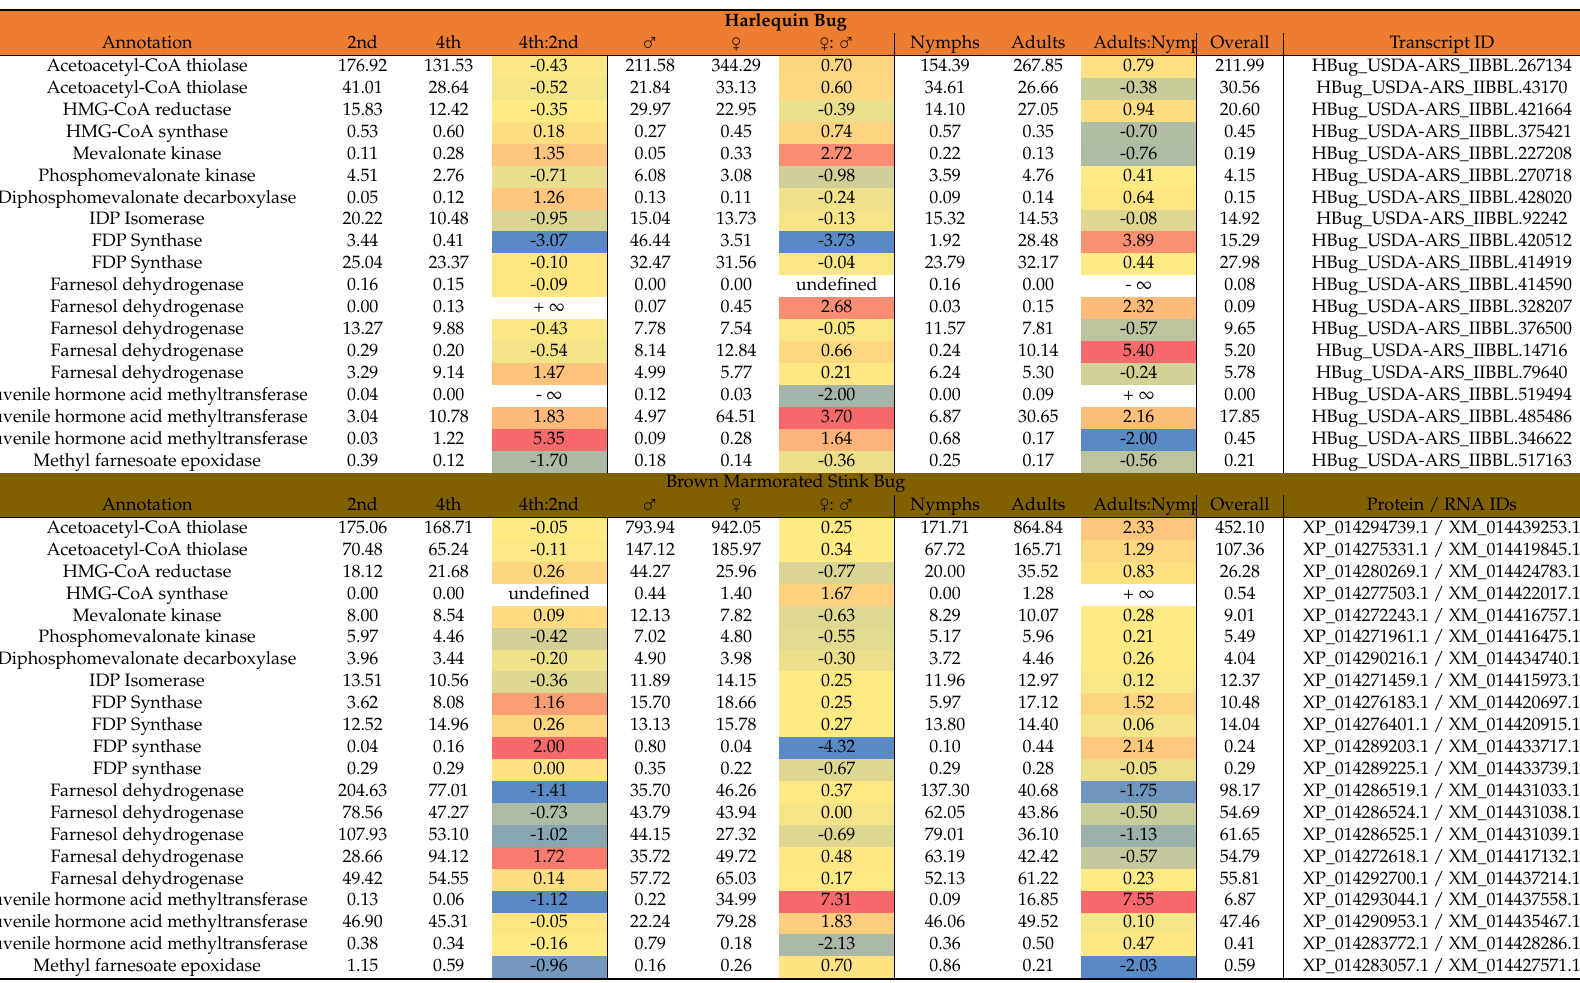
Table 6. Gene expression levels for Murgantia histrionica and Halyomorpha halys genes associated with terpene biosynthesis. RSEM-calculated expression values are conveyed in units of Transcripts per Million (TPM), and comparisons correspond to binary logs of TPM